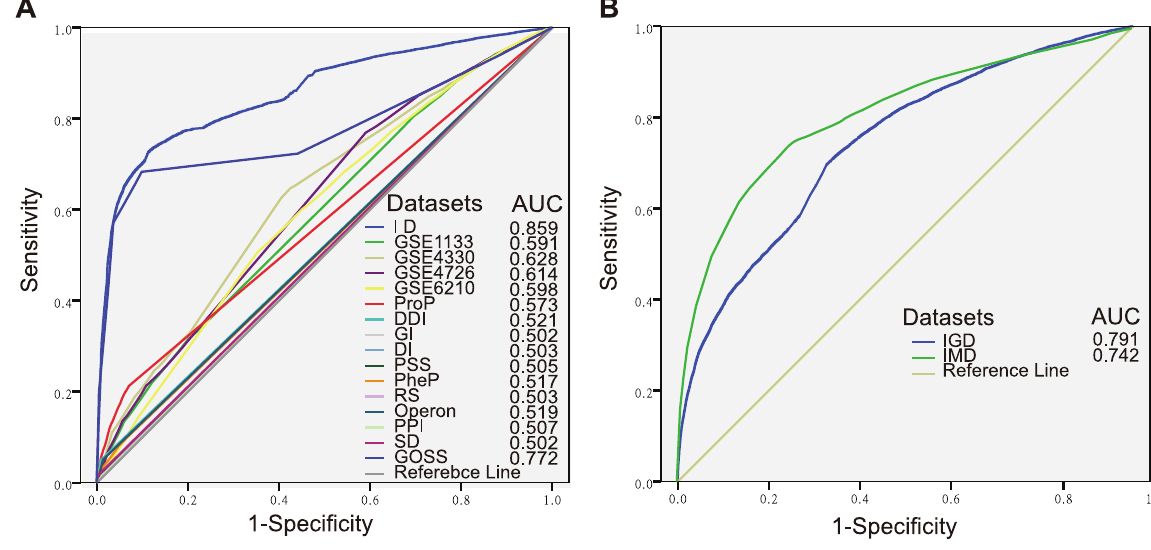
Figure 3. ROC curves for evaluating the performances of various data sources using cross-validations. (A) ROC curves and AUC of individual dataset and integrated dataset. The data sources are highlighted in different colors. (B) ROC curves and AUC of mitochondrial-specific (green) and genome-scale (blue) datasets. ID: Integrated datasets; ProP: Protein expression profiles; DDI: Domain-Domian Interaction; GI: Genetic Interaction; DI: Disease Involvement; PSS: Phenotypic Semantic Similarity; PheP: Phylogenetic Profiles; RS: Rosetta Stone; PPI: Protein-Protein Interaction; SD: Shared Domains; GOSS: GO Semantic Similarity; IGD: Integrated Genomic-scale Datasets; IMG: Integrated Mitochondrial-specific Datasets; ROC: receiver operating characteristic; AUC: area under ROC